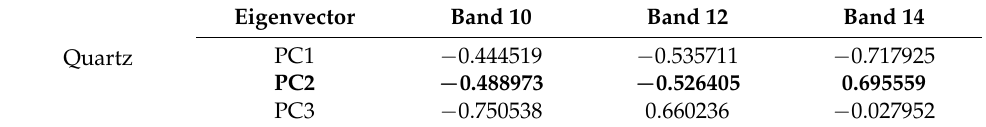
Table 4. Eigenvector matrix of the quartz calculated using the SPCA method for ASTER bands 10, 12, and 14.